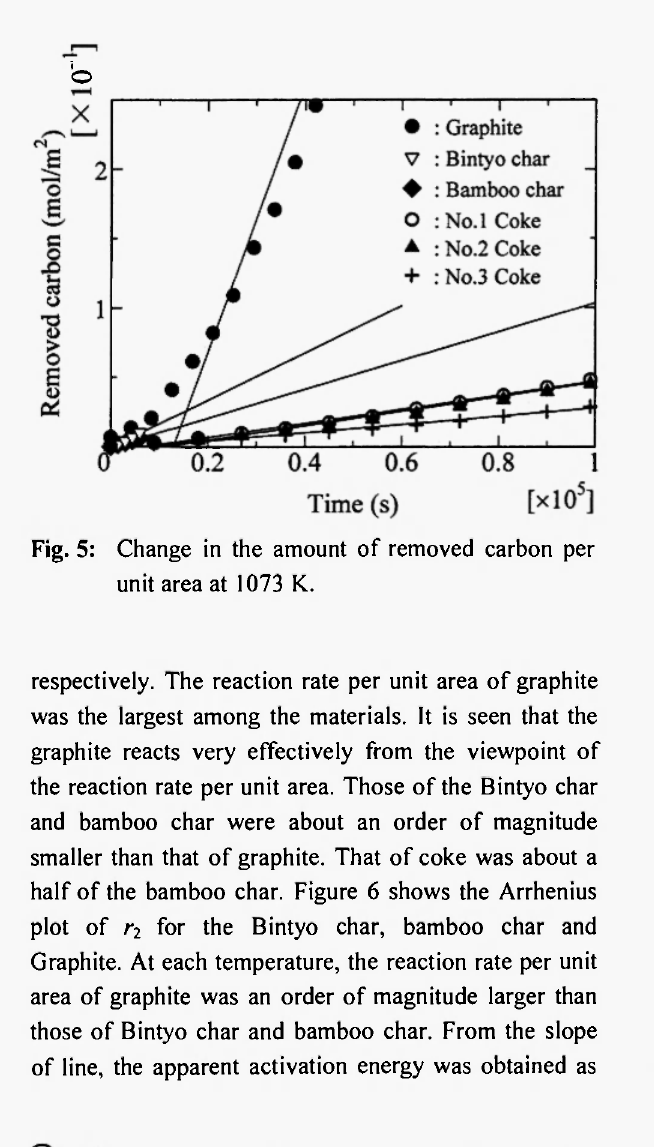
Fig. 7: Examples of transient response of CO desorption at 1073 K.